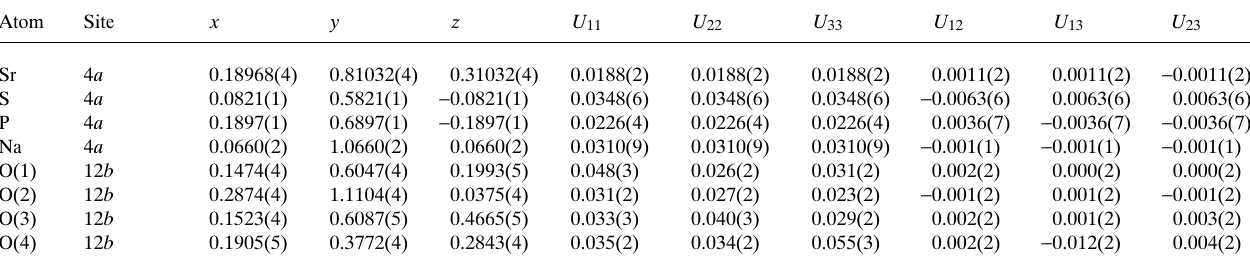
Table 3. Atomic coordinates and displacement parameters (in Å 2 ) .